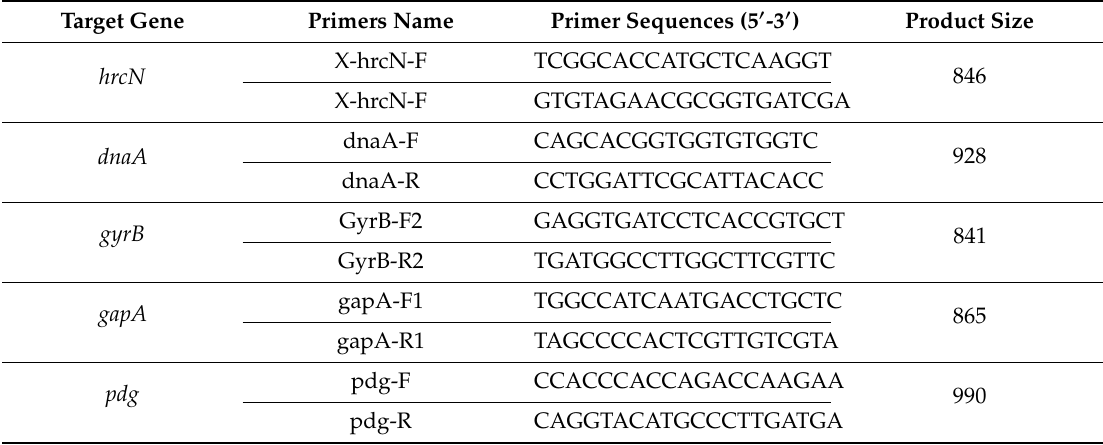
Table 2. Details of the primers used for PCR amplification of EscN / YscN / HrcN family type